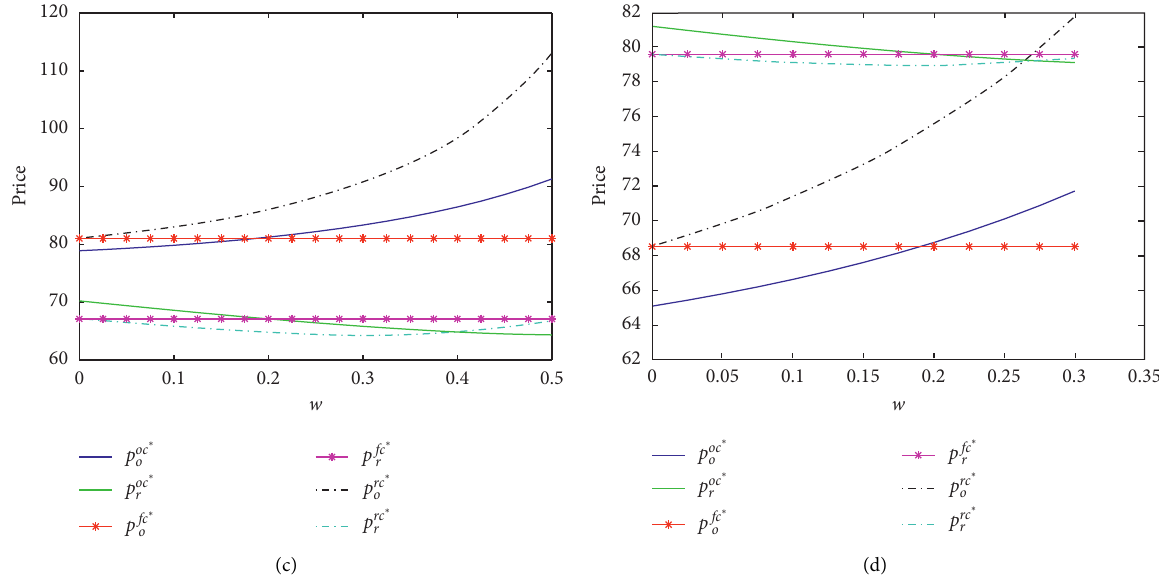
Figure 8: Effect of v and w on channel prices under different θ : (a) low θ ( θ � 0 . 35), (b) high θ ( θ � 0 . 65), (c) low θ ( θ � 0 . 35), and (d) high θ ( θ � 0 .